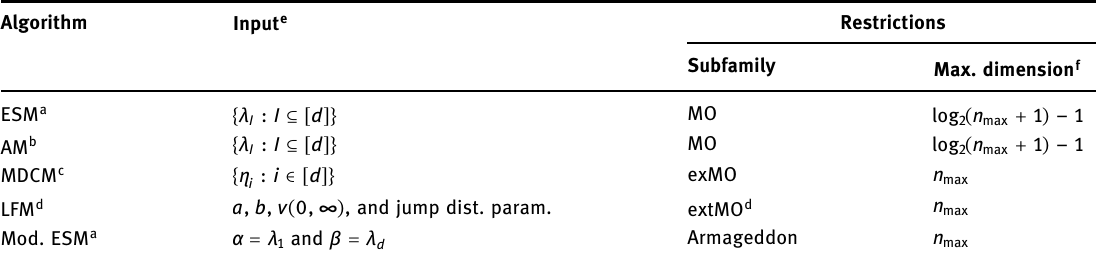
Table 1: An overview of our implementations for the runtime comparison; for more details on the software used, see our statement following the